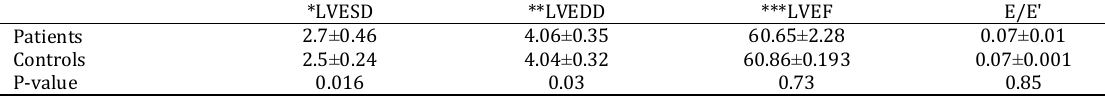
Table 2 . Two-dimensional and Doppler Echocardiographic Measurements in Patients and Control Subjects